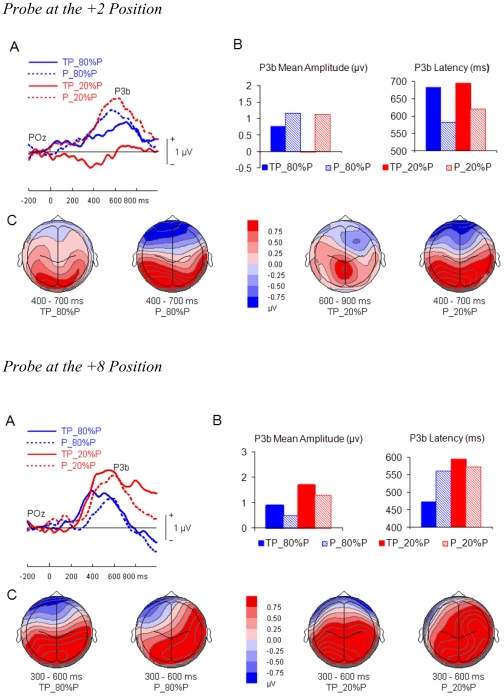
ERPs elicited by the probe at the +2 and the +8 positions.Group mean difference waves of probe-locked ERPs elicited by target-probe sequences minus target only sequences as a function of probe probability. Similarly, difference waves of probe-locked ERPs elicited by probe only sequences minus the sequences with neither the target nor the probe as a function of probe probability. A: traces from the parietal electrode POz. B: mean amplitude and latency from parietal electrodes (i.e., P3, Pz, P4, PO3, POz, and PO4). C: the bottom panel shows the topographic P3b amplitude distribution from the corresponding experimental conditions during peak latency. TP_80%P: both target and probe were present and 80% probe at the designated temporal position; P_80%P: only probe was present and 80% probe at the designated temporal position; TP_20%P: both target and probe were present and 20% probe at the designated temporal position; P_20%P: only probe was present and 20% probe at the designated temporal position.